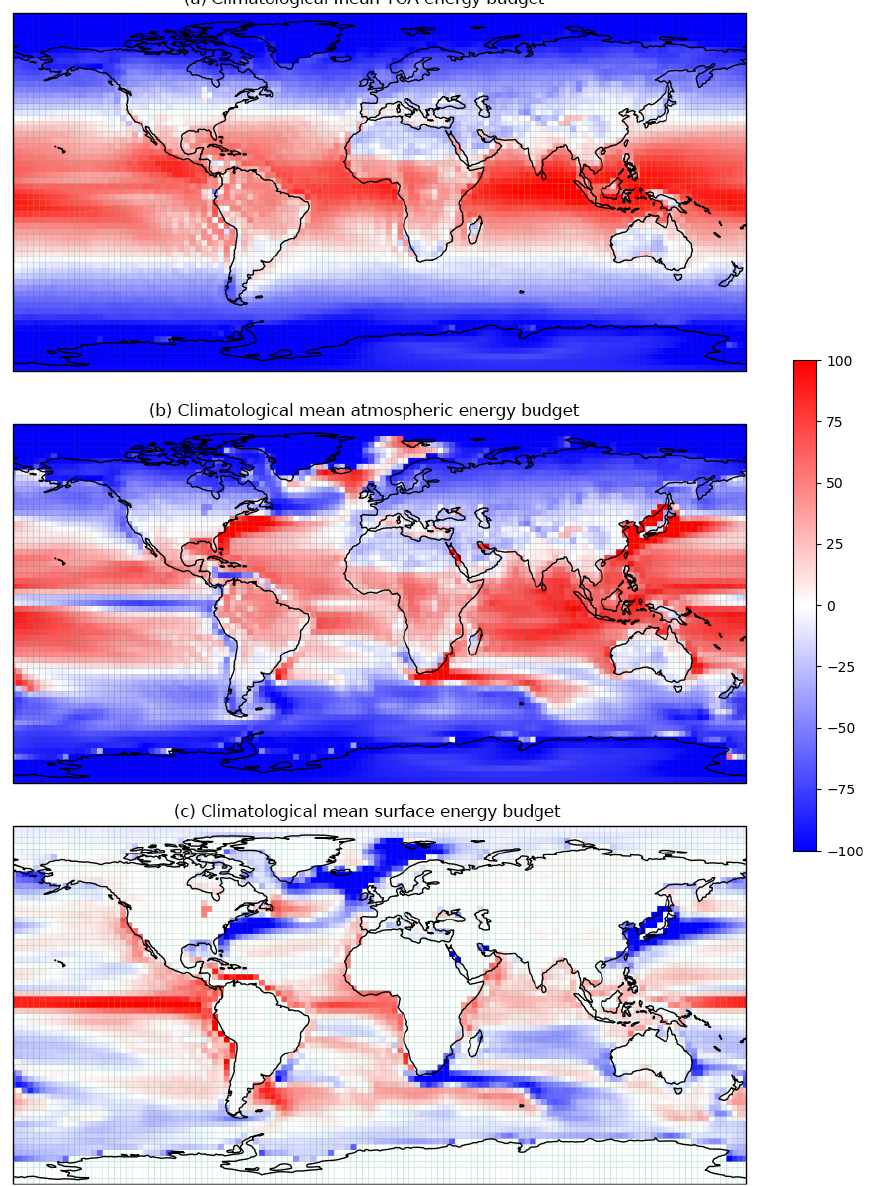
Figure 1. Climatological annual mean maps of (a) TOA, (b) atmospheric and (c) surface energy budgets for the CanESM2 model (Wm − 2 ). The fluxes are positive when entering the domain and negative when exiting the